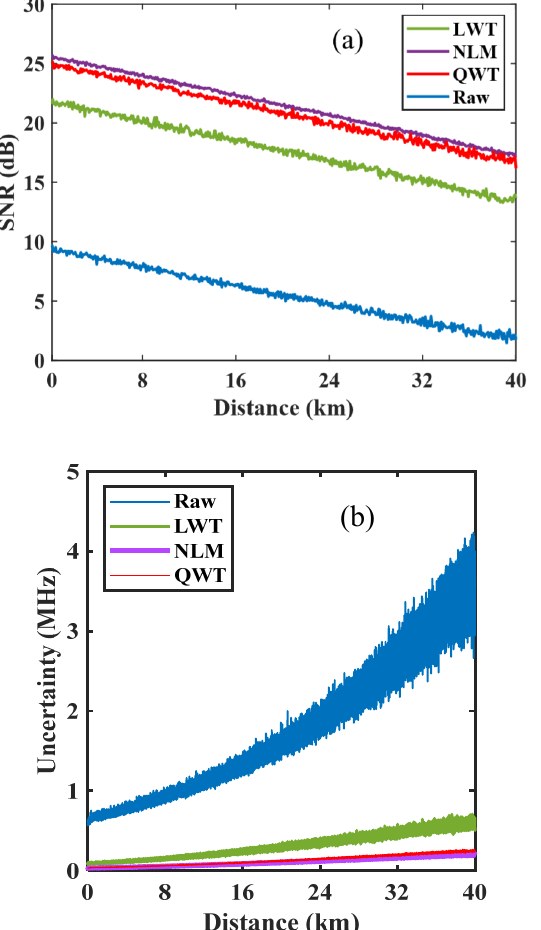
Figure 5. Denoising evaluation by calculated SNR ( a ) and frequency uncertainty of retrieved BFS ( b ). For extracting the temperature information from the denoised BGS image using a